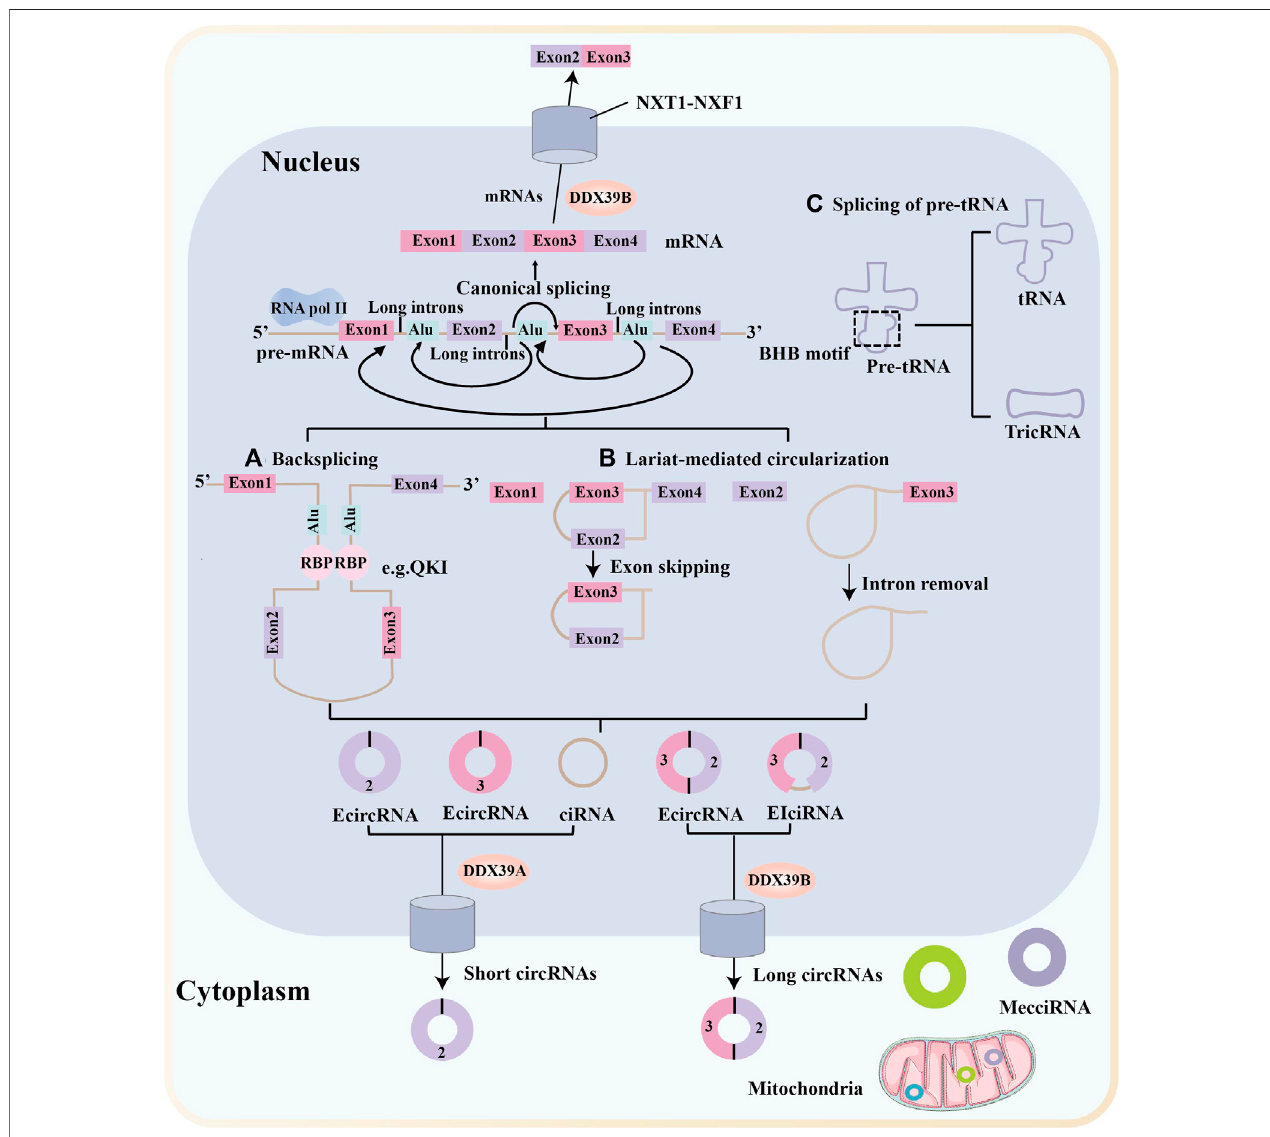
FIGURE 1 | Biogenesis and nuclear export of circular RNAs. Messenger RNA (mRNA) synthesis occurs via canonical splicing, in which exons are aligned to generate the mRNA. Most circular RNAs (circRNAs) are transcribed by RNA polymerase II (Pol II) and formed by back-splicing of precursor mRNAs. Many circRNAs, especiallythoseoflowabundance, areformedasaresultofbasepairingbetweenlong fl ankingcomplementary intronscontaininginvertedrepeatelements,such asAlu repeats. (A) CircRNA biogenesis is fi ne-tuned by trans-acting RNA binding proteins (RBPs). (B) Another circRNA biogenesis model is the lariat-driven circularization, which occurs inexon-skipping events(left) or during intron removal from pre-mRNAs (right). (C) TricRNAs are another type ofcircRNA that aregenerated via the splicing of pre-tRNA. MecciRNAs are mitochondria-encoded circRNAs that are distributed in the mitochondria and the cytoplasm. Export of circRNAs from the nucleusrequirevariousproteinsandoccurinalength-dependentmanner.DDX39BregulatethenuclearexportoflongcircRNAs( > 1,300nucleotides),whereasDDX39A regulate the nuclear export of short circRNAs ( < 400 nucleotides). NTF2-related export protein 1 (NXT1)-nuclear RNA export factor 1 (NXF1) heterodimeric export receptor recruit some complexes and release into the